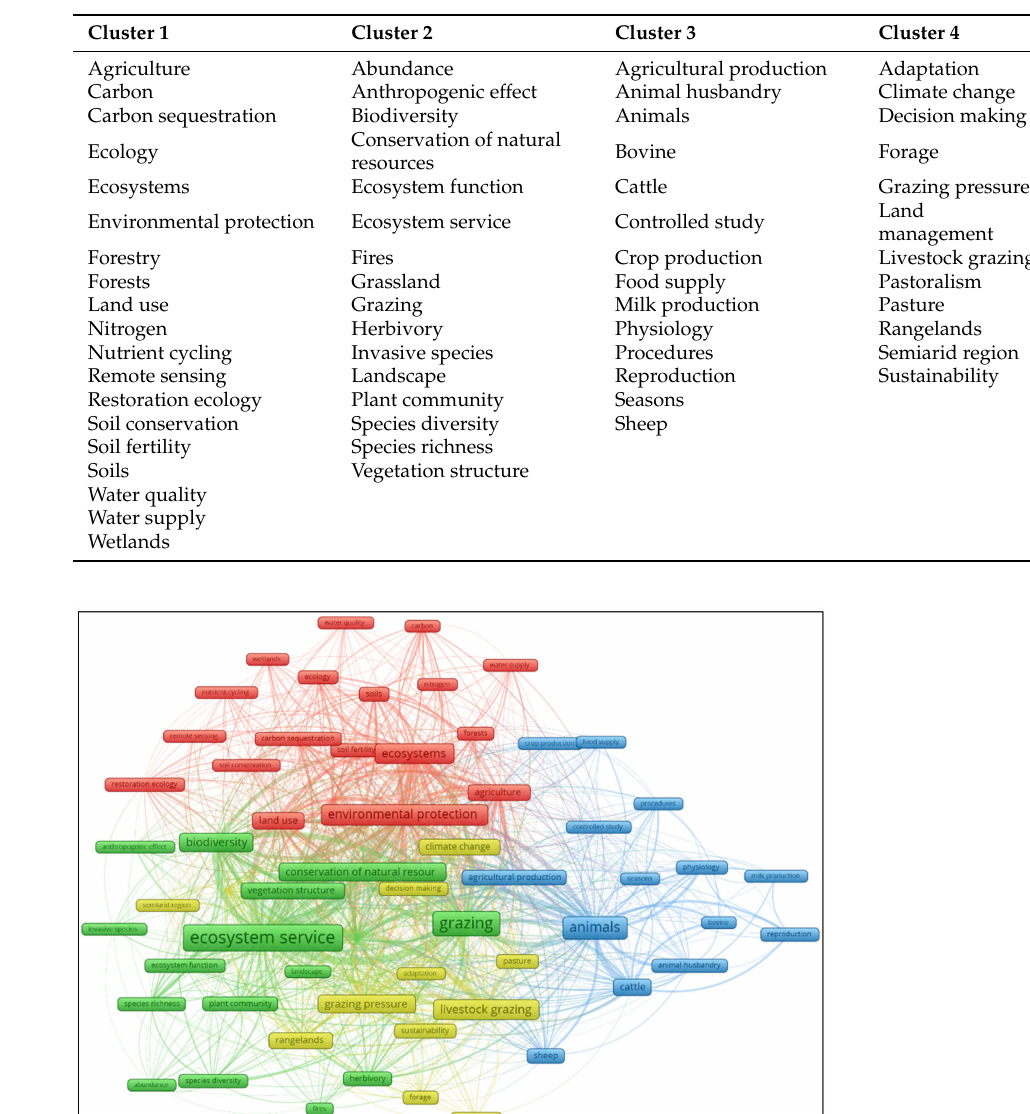
Table 2. Keywords found in the documents analyzed according to the clustering made with VOSviewer. The minimum number of times each term included in those clusters needed to ap- pear was set at 40.